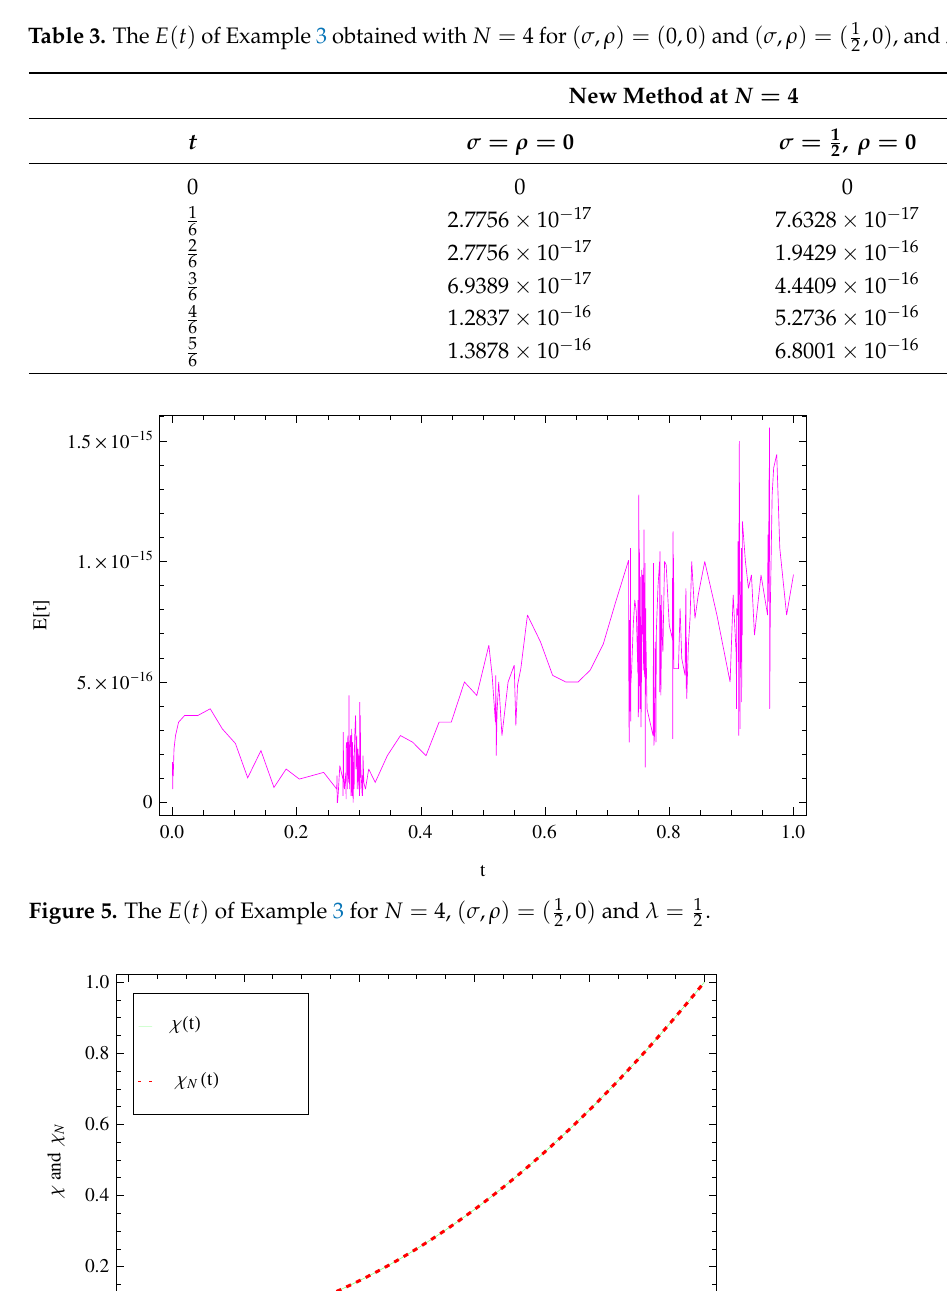
Table 3. The E ( t ) of Example 3 obtained with N = 4 for ( σ , ρ ) = ( 0,0 ) and ( σ , ρ ) = ( 1